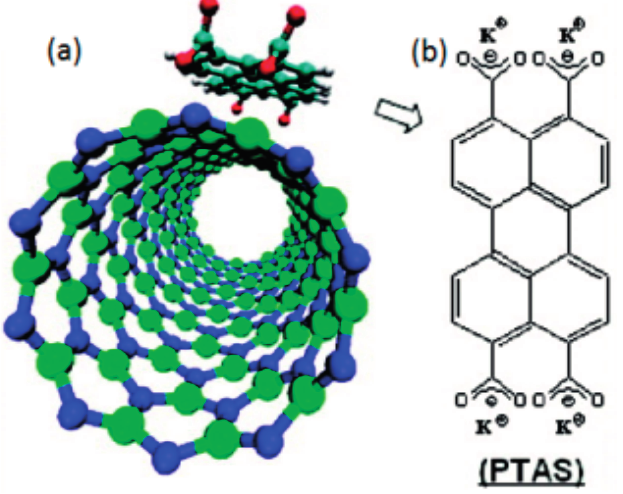
Figure 6. ( a ) A schematic diagram of non- covalent functionalization of BNNT with a PTAS molecule; ( b ) PTAS molecule. Reprinted with permission from [134]; © 2008 American Chemical